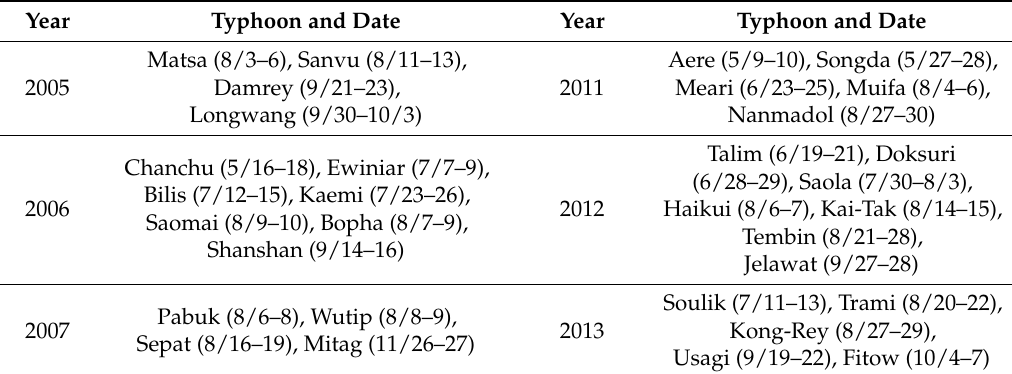
Table 1. Typhoon incidents between 2005 and